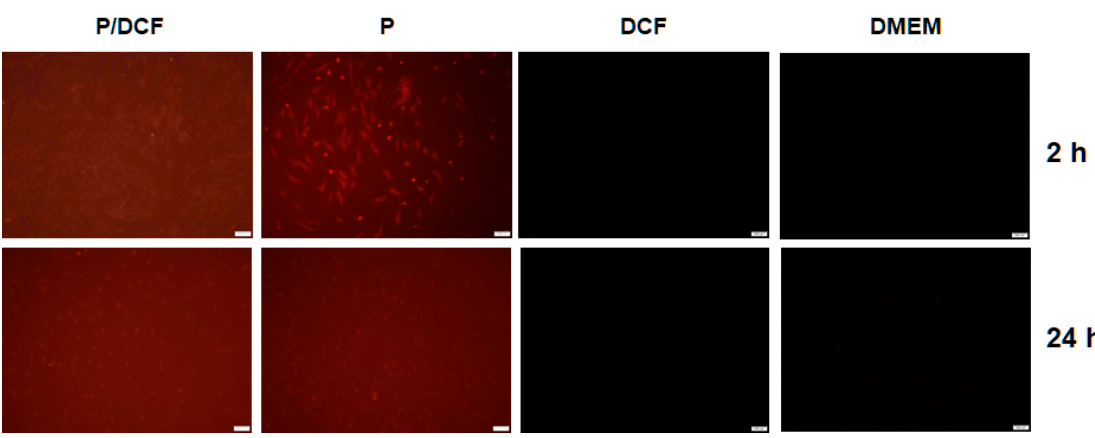
Figure 6. Detection of live fluorescence in human mesenchymal stromal cells (hMSCs) treated with PolyCD-based nanoassemblies (2 mg/mL). hMSCs (2 × 10 4 cells/well in 24-well plates) were directly incubated with the compounds and live fluorescence was monitored after 2 and 24 h by fluorescent microscopy as described in the Materials and Methods (scale bars: 200 µm). Abbreviations: P/DCF: